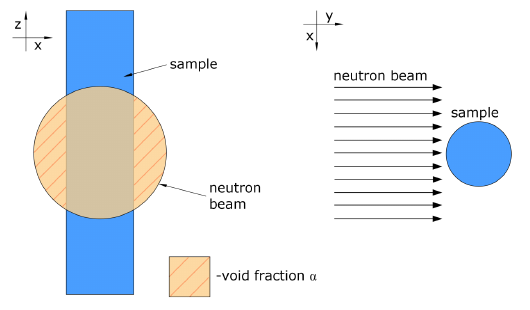
Figure 2. Schematic presentation of the MINERVE sample in the neutron